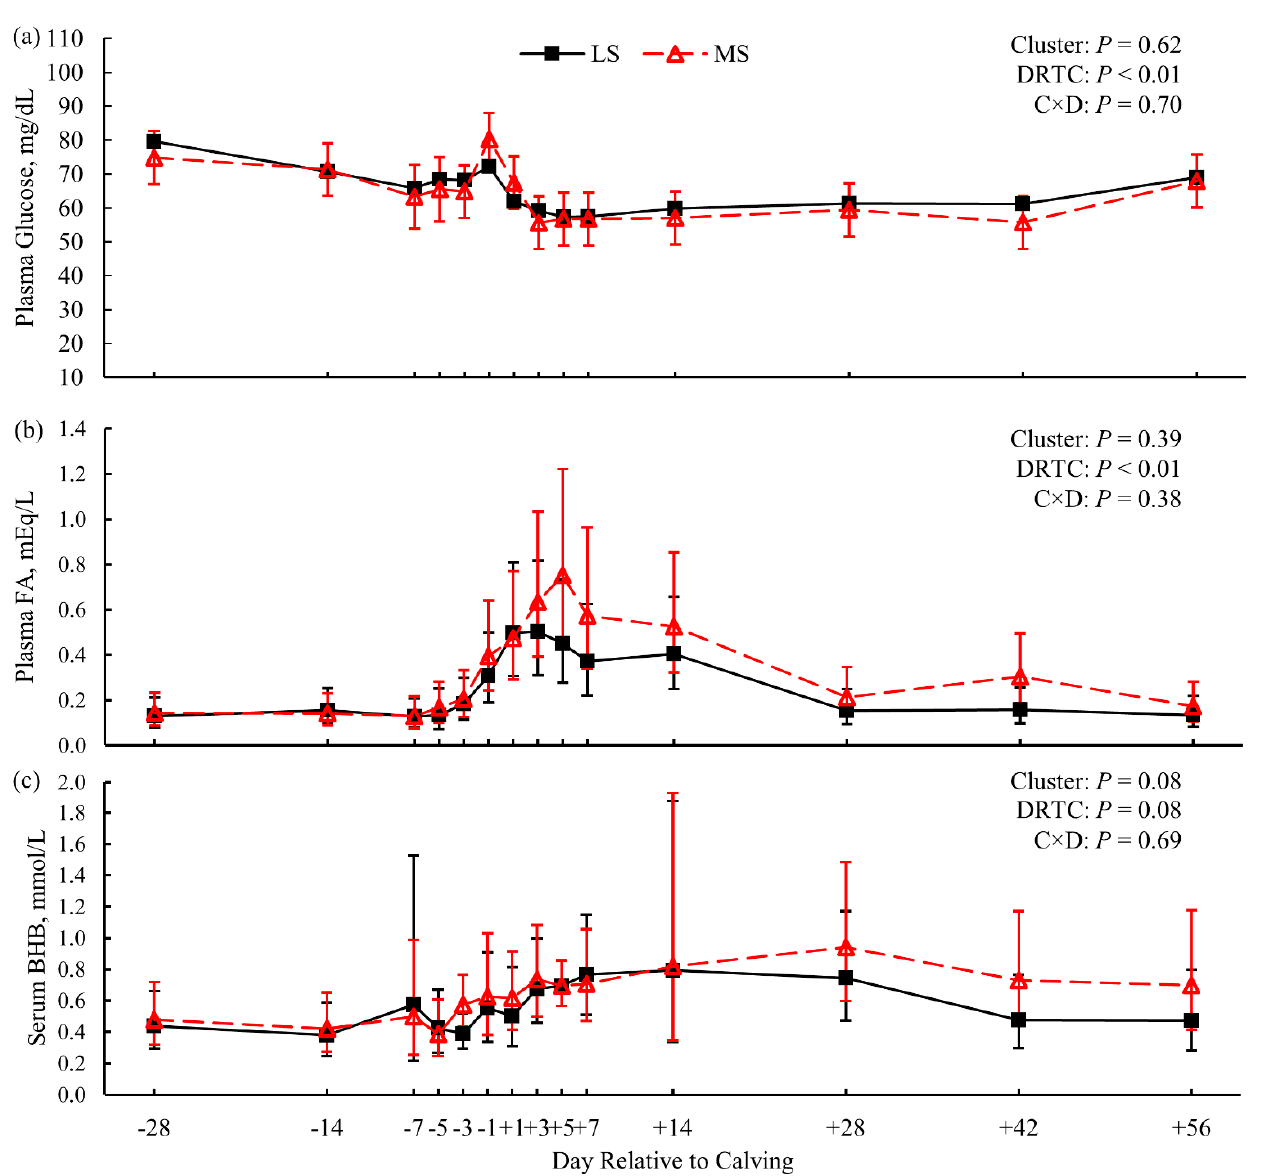
Figure 2. Blood fraction concentrations of glucose (panel a ), fatty acids (FA; panel b ), and β -hydroxybutyrate (BHB; panel c ) for dairy cows less (LS) or more (MS) susceptible to lipid-related metabolic disorders ( n = 3 cows per cluster). Data are presented as least squares means (points) and their 95% confidence intervals (error bars). Statistics for the fixed effects of cluster, day relative to calving (DRTC), and their interaction (C × D) are displayed in the top-right corner of each panel. Contrasts of cluster across postpartum samples did not reveal additional evidence of differences ( p > 0.10; panels a and b ).